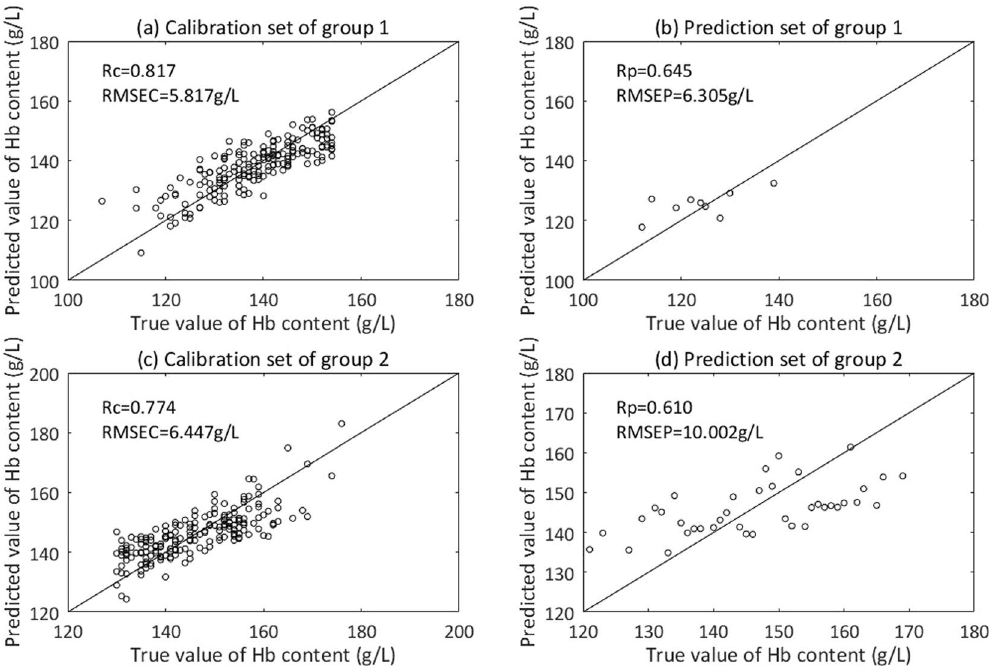
Figure 10. Scatter plot of true value and predicted value of Hb content by grouping modeling. ( a ) Calibration set of group 1. ( b ) Prediction set of group 1. ( c ) Calibration set of group 2. ( d ) Prediction set of group